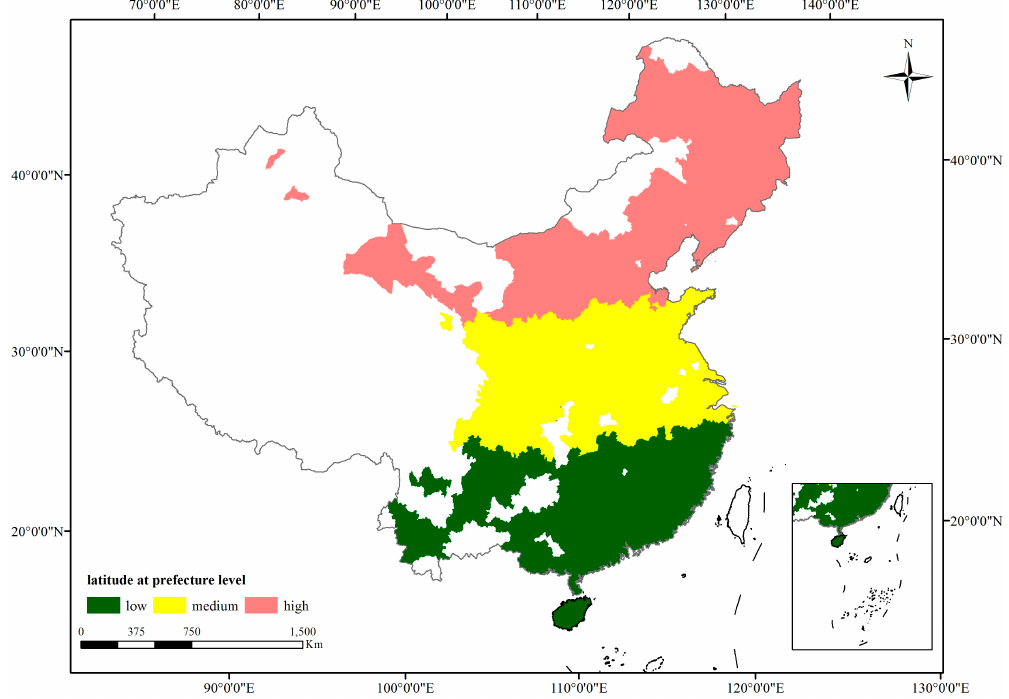
Figure A1. Classifications based on latitude at prefecture level.